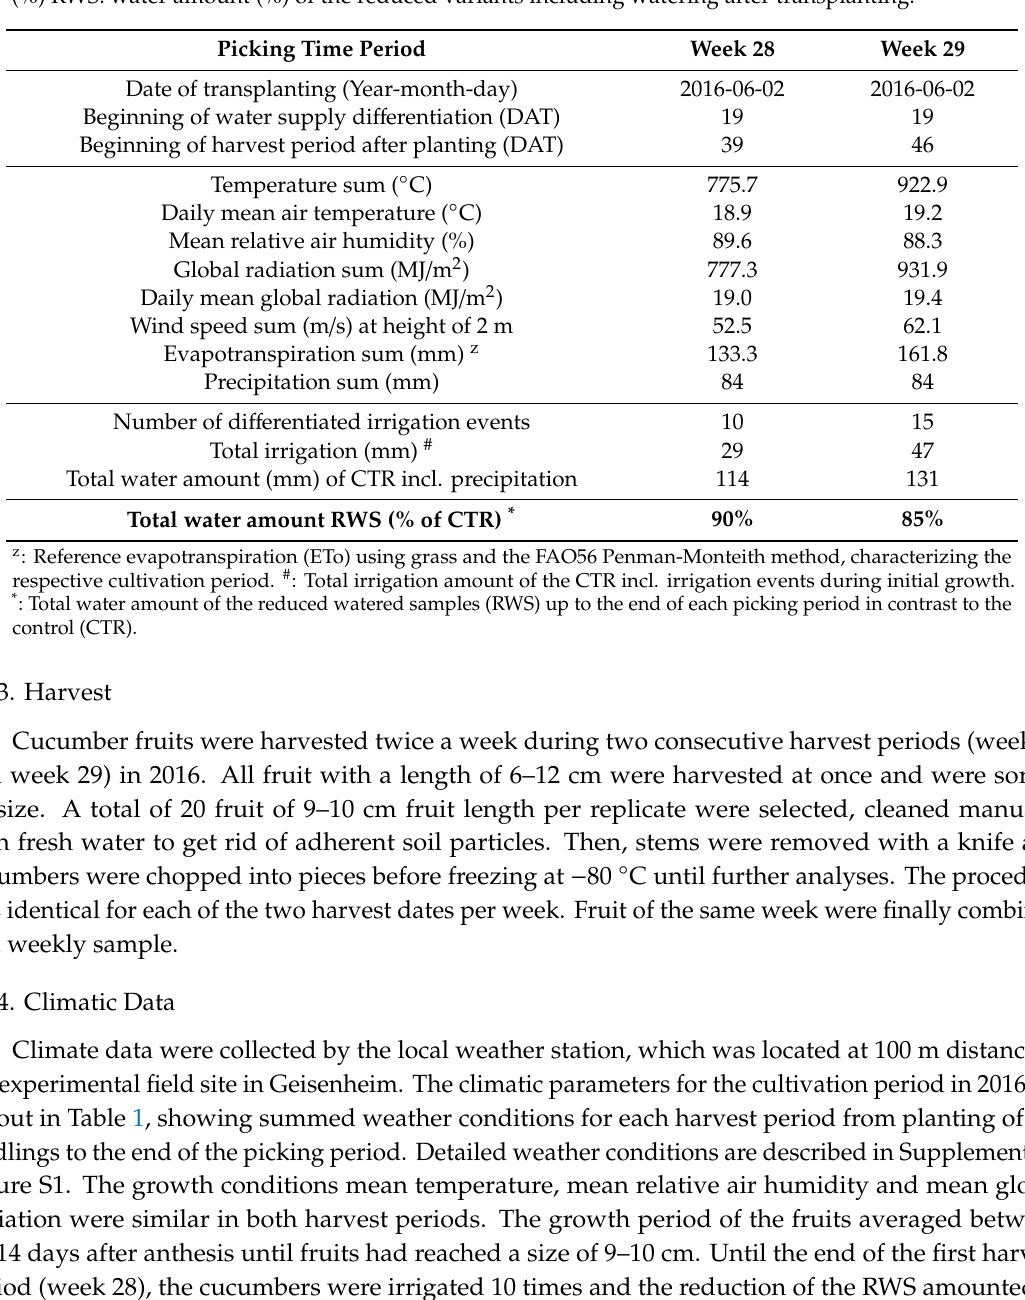
Table 1. Cultivation and climate data of the cucumber cultivation set in 2016 summed up for each picking period from transplanting to the end of the respective harvest period. DAT: Days after transplanting. Irrigation (mm): Total irrigation amount including irrigation during initial stage. Total water amount (%) RWS: water amount (%) of the reduced variants including watering after transplanting. Picking Time Period